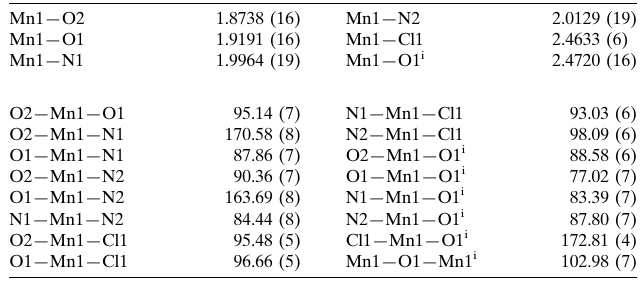
Selected geometric parameters (A˚ , (cid:1)